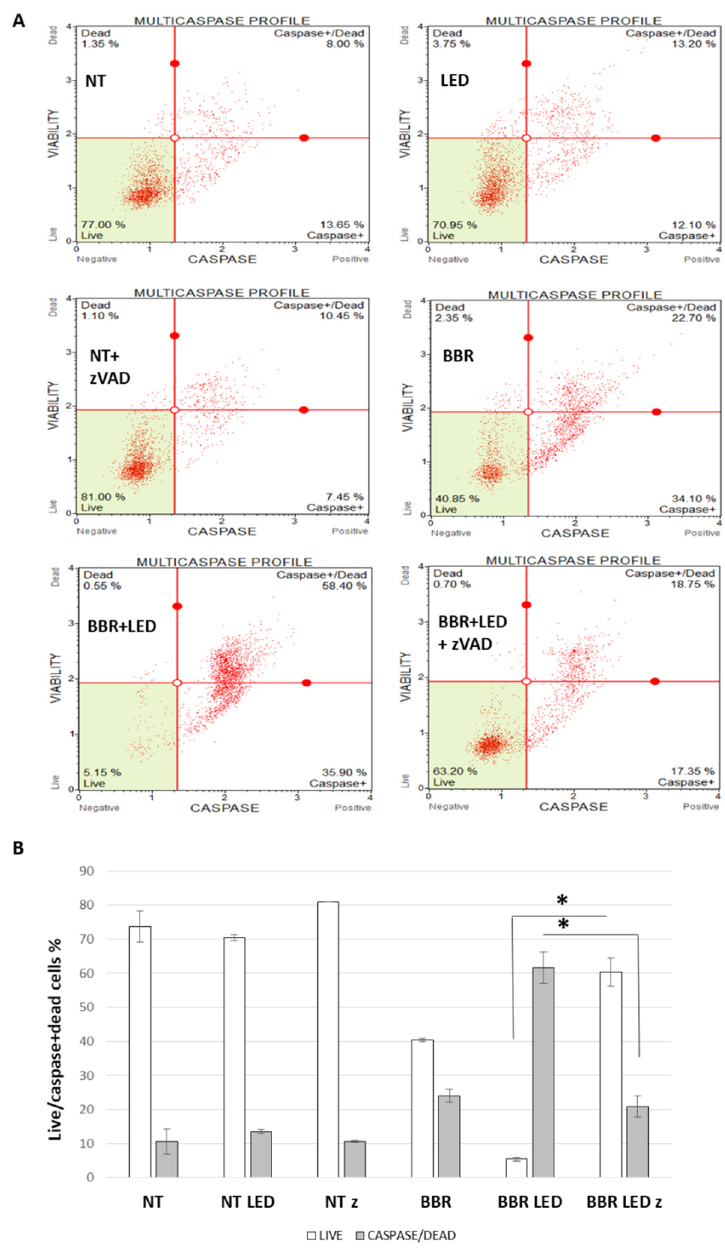
Figure 9. Caspase cytometric analysis of BBR and PDT scheme following a pan-caspase interference. Cytofluorimetric analysis of caspase activation in T98G cells as untreated (NT), exposed to LED stimulation (LED), BBR (200 μ g/mL for 4 h) administration, with the combined LED+BBR after and in presence of 100 μ M z-VAD(OMe)–FMK inhibitor of pan-caspases, evaluated at 24 h p.t. ( A ). Trypsinized cells were analyzed for apoptosis induction using the Muse MultiCaspase kit (Luminex). The histogram of the live/dead cells percentages of two independent experiments is reported ( B ). Asterisks indicated statistical significance of live and caspase/dead BBR + LED with inhibitor (z), compared to BBR + LED treated cells ( p < 0.05, Anova One-way).